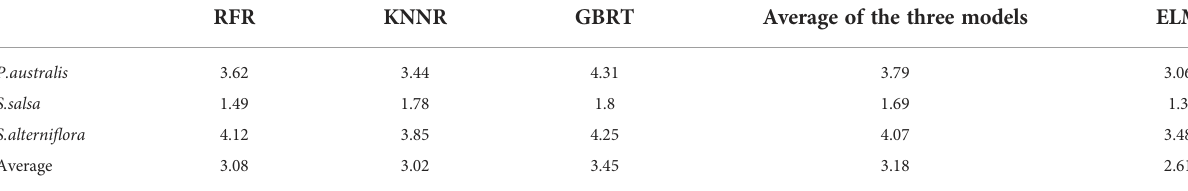
TABLE 3 MAE (%) of the estimated fractional cover based on cloud-removed images in Scenario 1. RFR KNNR GBRT